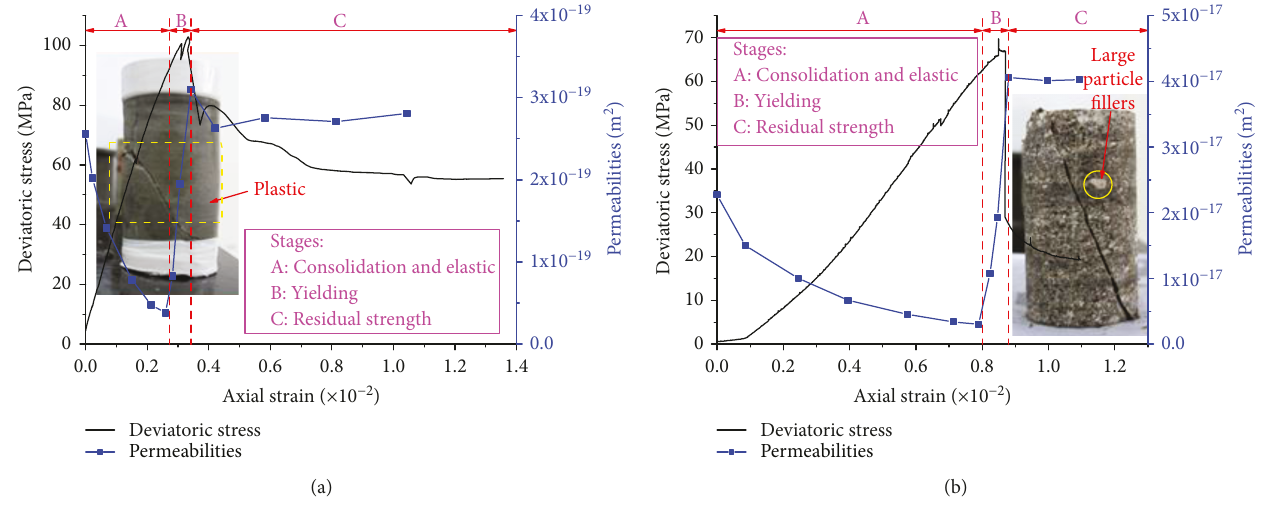
Figure 2: Variations in the permeability of weakly cemented rock during the process of complete stress-strain. Table 2: Summary of rock permeabilities in di ff erent stages during the process of complete stress-strain. Lithology k 0 (m 2 ) Mudstone Shaly coarse